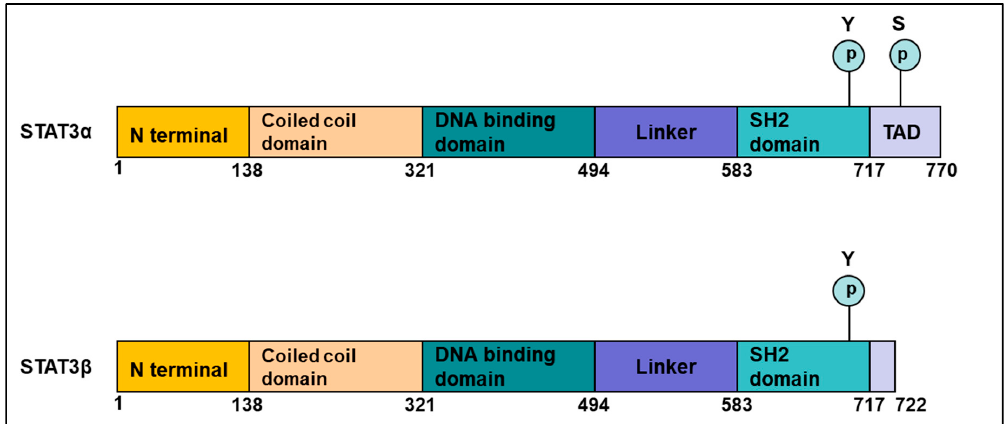
Figure 1. The molecular structure of the two STAT3 isoforms. The STAT3 molecule consists of several distinct domains:(i) the N-terminal domain containing an oligomerization and a